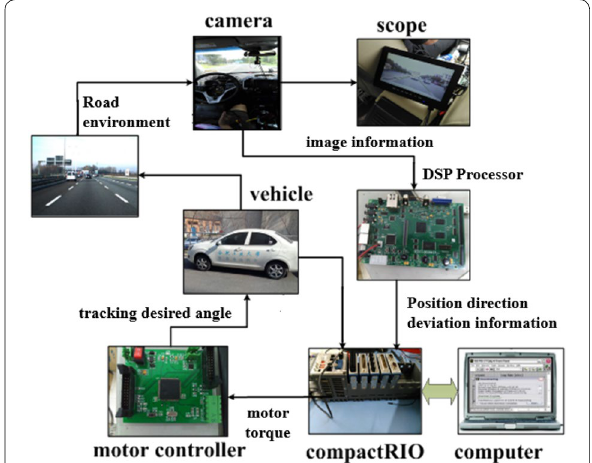
Figure 12 Structure of real vehicle experiment